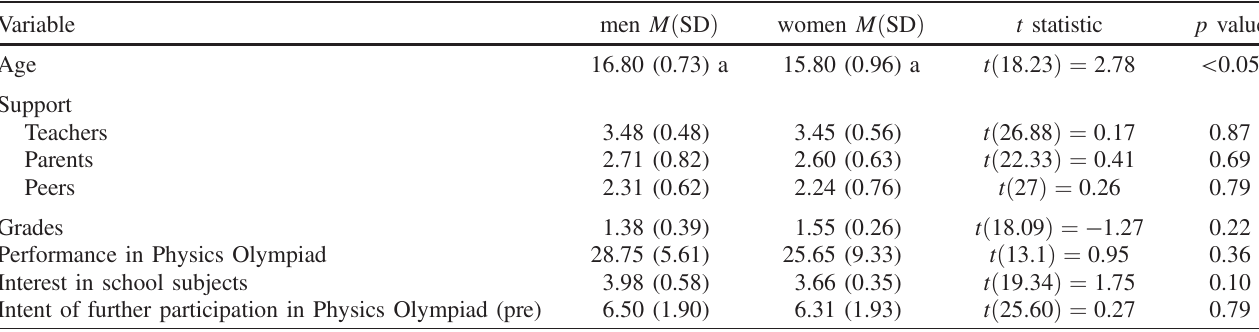
TABLE II. Sample differences in background variables with respect to students ’